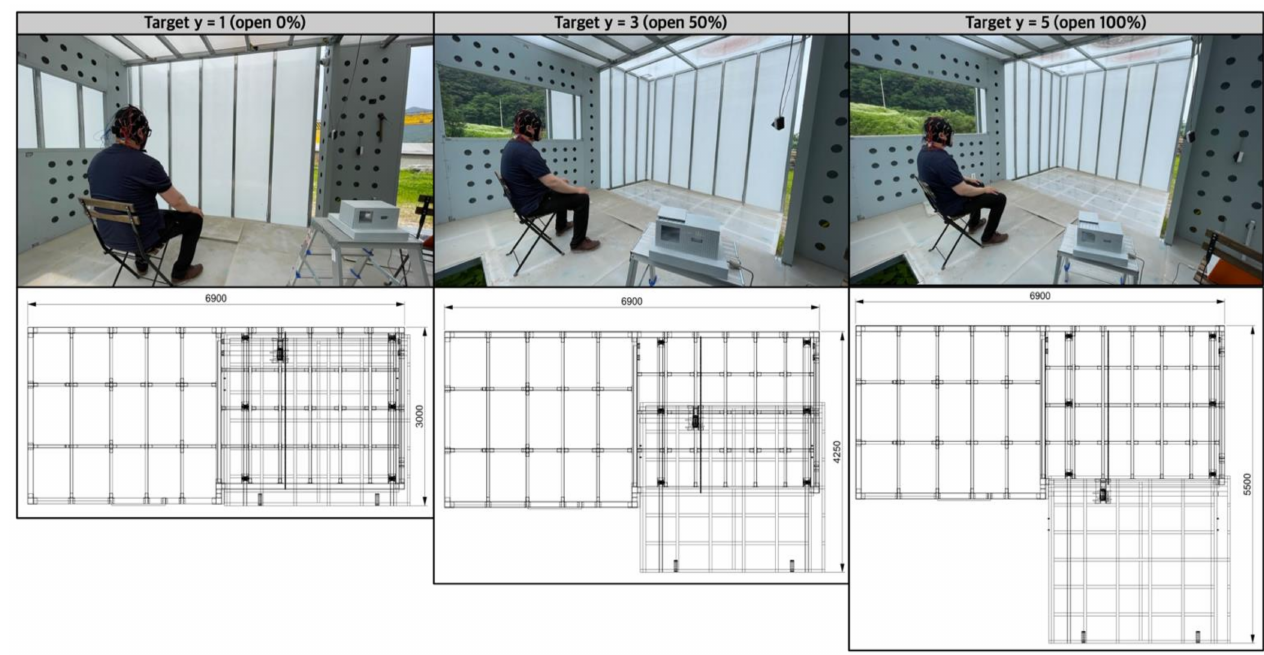
Figure 11. The process of applying the method to the real space structure. CTR prediction was performed using DeepFM, and based on the range of the pre- dicted value, the point at which the smart space moves was designated to be between Nos. 1 and 5 for recommendation. A total of 10 experiments were conducted for 10 min each, and after applying the user’s EEG to DeepFM according to the space situation, the three cases of DT- virtual, semi-real, and real, were applied sequentially. Fifty-nine space transformations were performed in a total of 100 min. After the space change, the